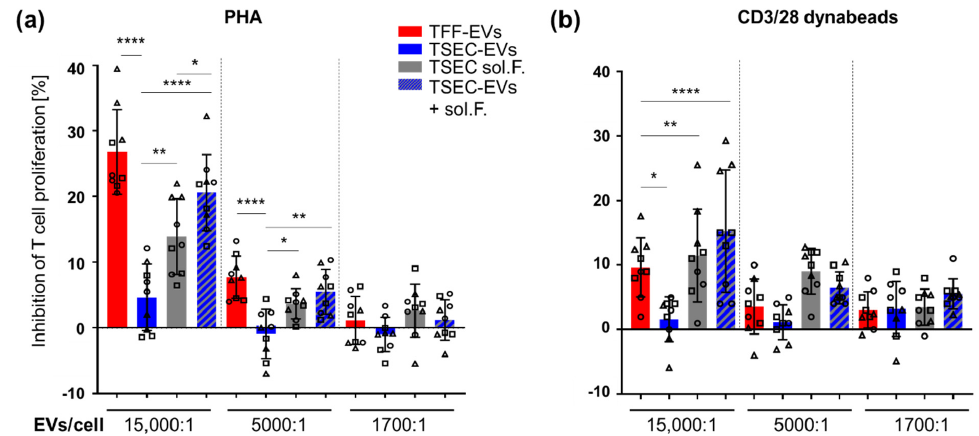
Figure 4. TSEC-EVs inhibit T-cell proliferation in the presence of platelet proteins. Peripheral blood mononuclear cells (PBMCs) containing app. 80% T cells [37,38] were incubated with different concentrations of TFF-EVs, TSEC-EVs, matching TSEC-soluble fractions or the combination of both (TSEC-EVs + soluble fraction add-back) for 4 days. ( a ) Proliferation of T cells was induced by phytohemagglutinin (PHA) and inhibition of T cell proliferation was most effective in the presence of TFF-EVs and TSEC-EVs + soluble fraction add-back. TSEC-EVs showed virtually no effect and TSEC-soluble fractions had a partial inhibitory effect. ( b ) After CD3/28 stimulation, a significant loss of function was observed comparing TSEC-EVs to TFF-EVs for their capacity to inhibit T cell proliferation. No significant difference was found between TSEC-soluble fractions and TSEC-EVs + soluble fractions add-back, both inhibiting T cell proliferation. One-way ANOVA, repeated measures, **** p ≤ 0.0001, ** p ≤ 0.01, * p ≤ 0.05. Each symbol (circles, squares and triangles) represents a different biological replicate ( n = 3) performed in triplicate.